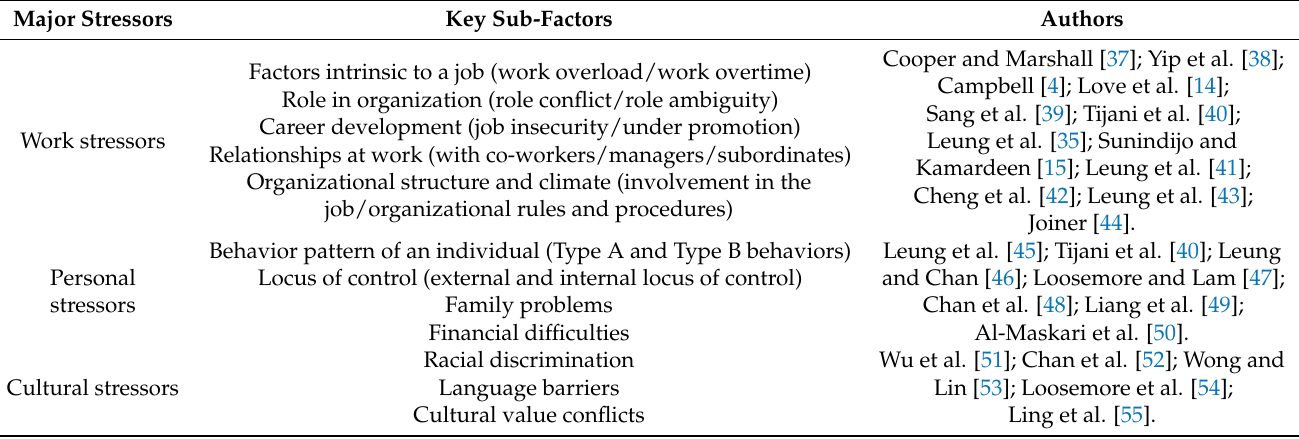
Table 1. Major stressors of construction workers’ mental